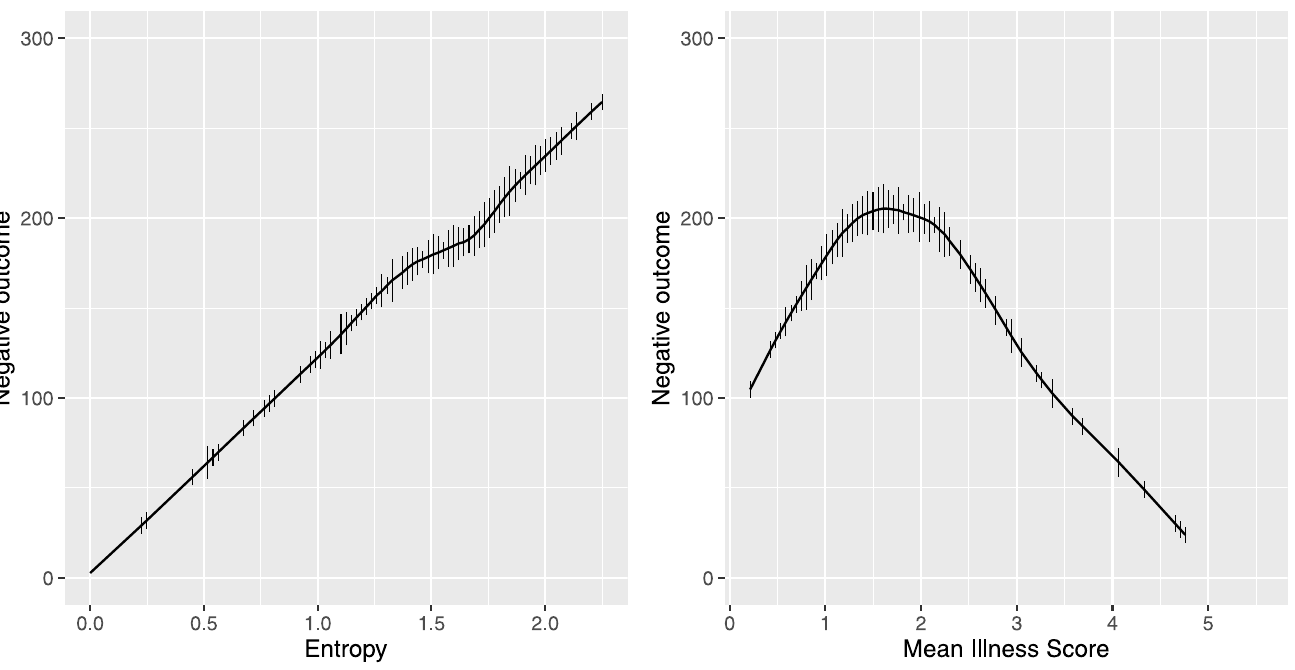
Fig 8. Nonparametric regression. Negative outcome scores as a function of (A) entropy and (B) illness scores. Nonparametric regression (loess, a moving least squares linear regression smoother) estimates of the relationship between the composite variable negative outcomes and the independent variables. Tick marks depict the mean illness scores and entropy distributions. Entropy was significantly associated with the negative outcome composite variable in a univariate analysis ( β = 107.6, 95% CI 69.0–146.1; p < 0.001, R2 = 0.16). After controlling for the mean illness score, entropy remained significantly associated with negative outcomes ( β = 92.8, 95% CI 23.0–162.6; p = 0.009, R2 = 0.20).